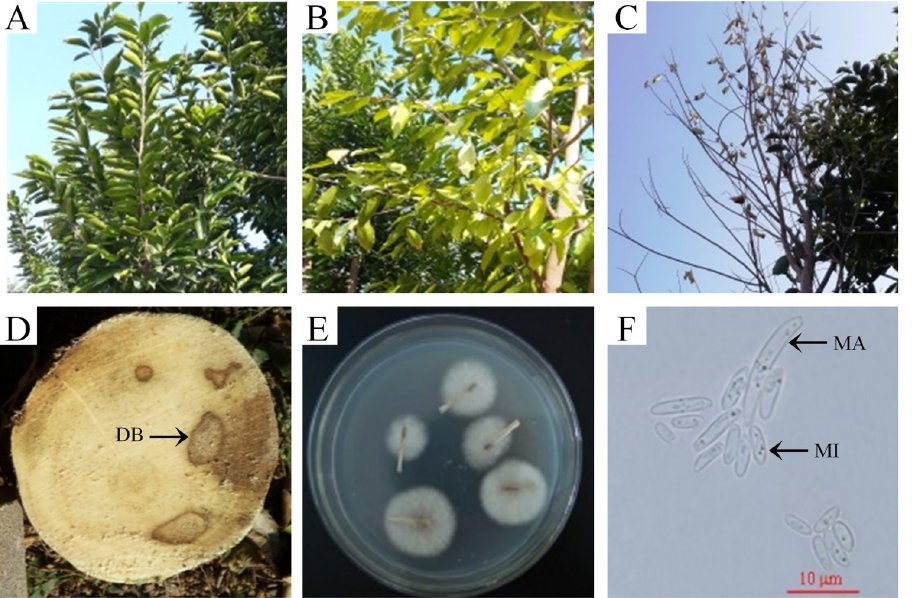
Fig 1. Symptoms of vascular wilt in A . sinensis trees and morphological characteristics of F . oxysporum isolated from an infected tree. (A) Healthy tree branches. (B,C) Infected tree with yellowing, defoliation. (D) Symptoms after infection. A . sinensis stems are dark brown (DB) when infected by pathogens. (E) Fungal colonies formed on PDA after three days. (F) Microconidia (MI) and macroconidia (MA) of a 10-day-old F . oxysporum culture on PDA.